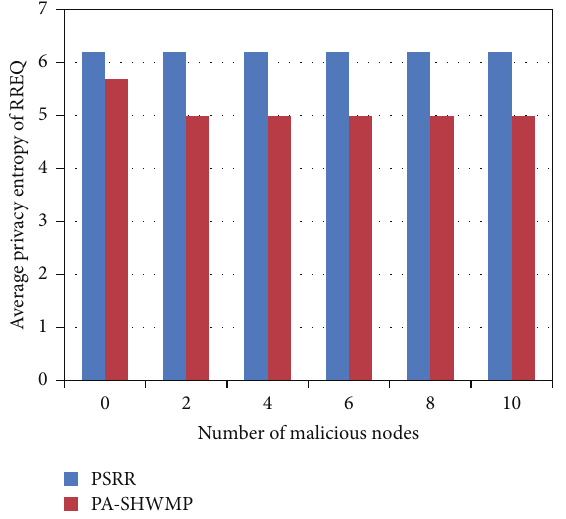
Figure 3: Route Acquisition Delay versus number of malicious nodes.